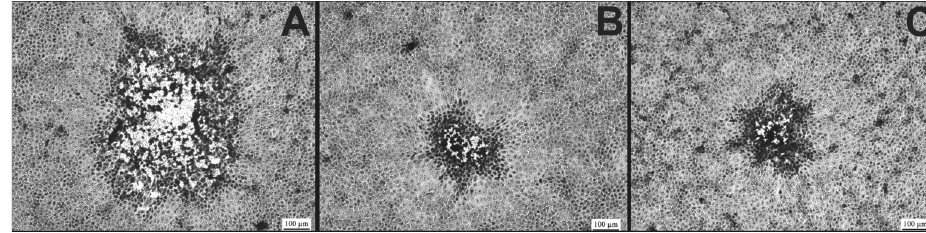
Figure 4. Plaque morphology of the parental virus and the recombinant BoHV-1 Δ gE viruses. Plaque assays were performed in MDBK cell monolayers overlaid with 1.6% carboxymethylcellulose and stained with crystal violet at 72 h. A , Parental virus (SV56/90 strain); B , BoHV-1 Δ gE#2; C , BoHV-1 Δ gE#3.